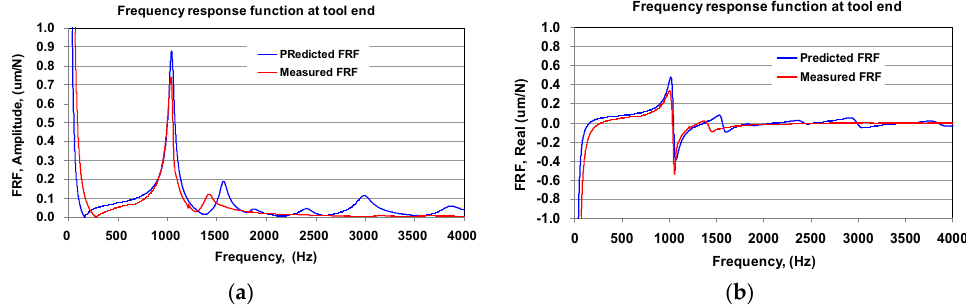
Figure 6. Comparisons of the frequency response functions measured from the spindle unit and predicted by the spindle model. ( a ) Amplitude of the FRFs, ( b ) Real part of the FRFs.